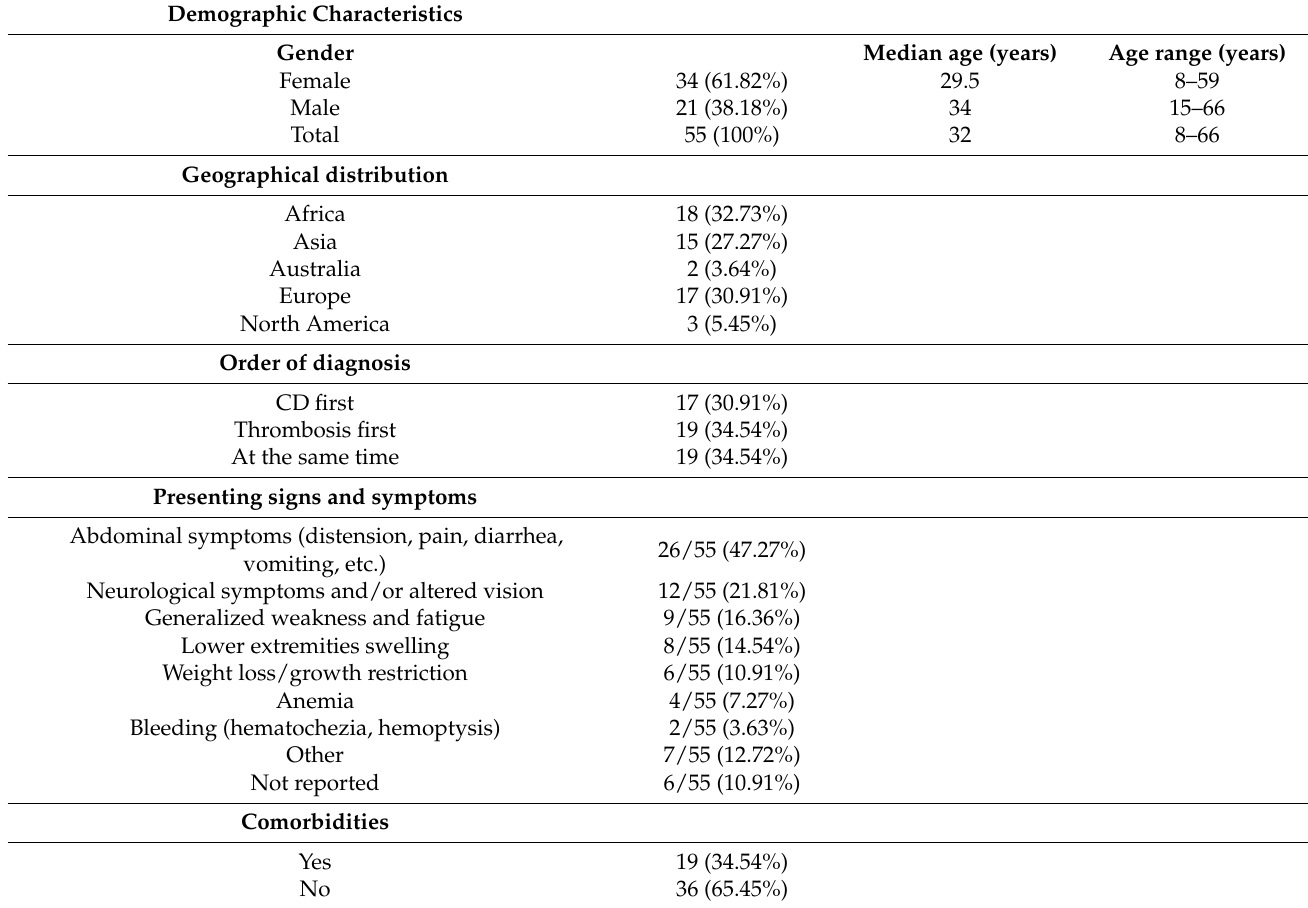
Table 1. Demographics, clinical presentation and risk factors for thrombosis in reported cases of thrombotic events in celiac